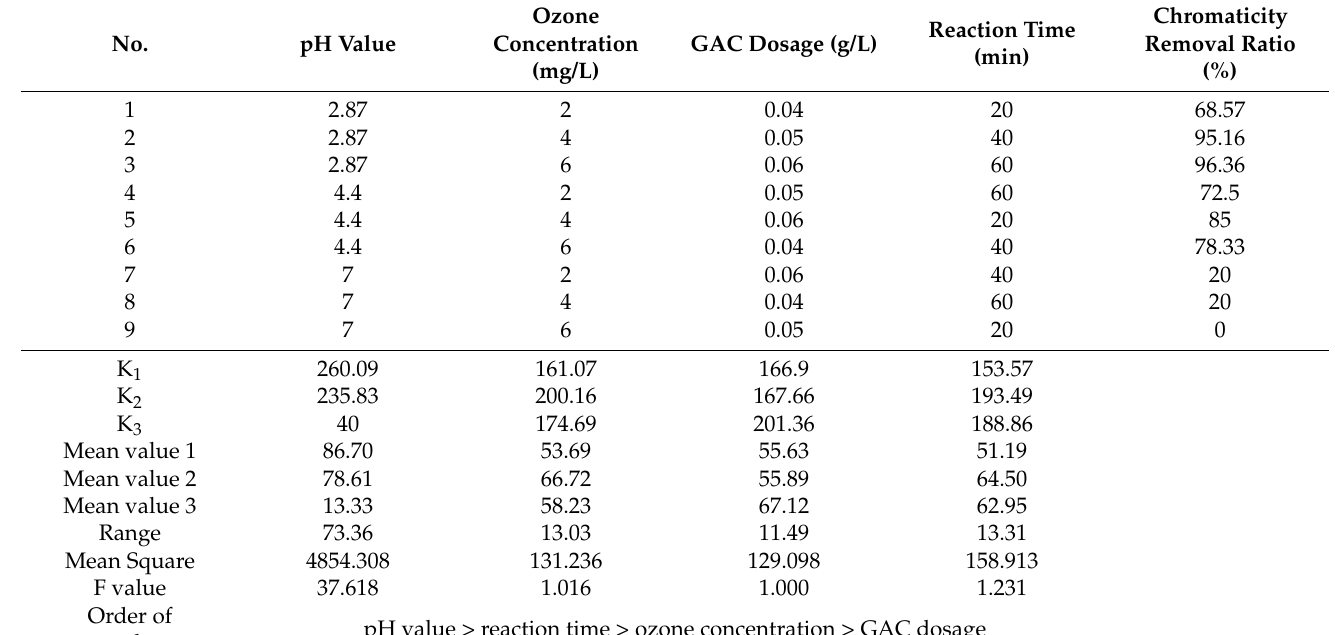
Table 1. Analysis of L 9 (3 4 ) orthogonal